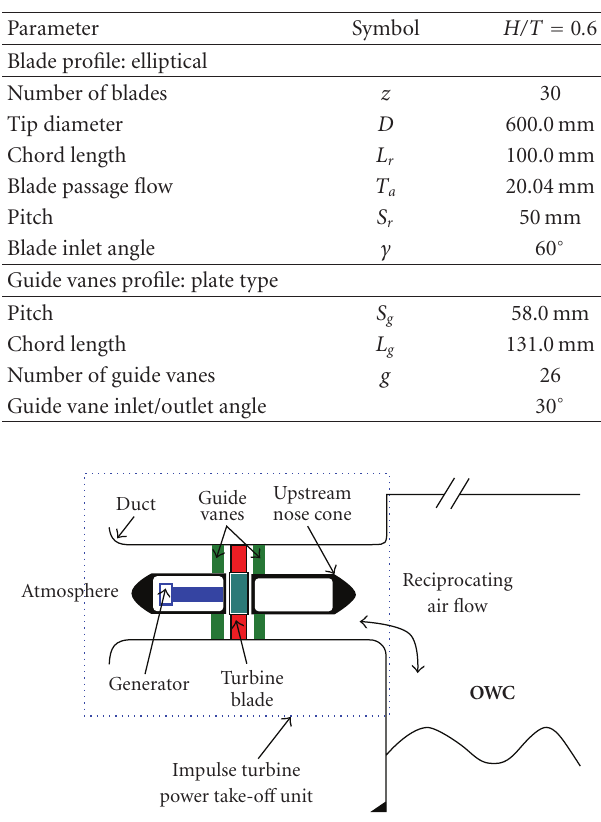
Table 1: Rotor and guide vanes geometry.